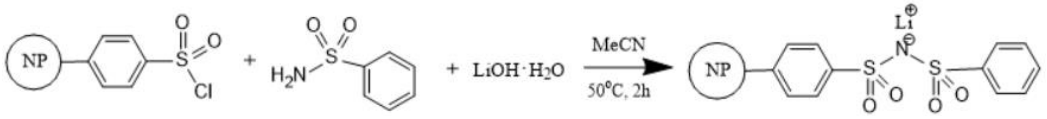
Figure 2. Synthesis of PSPhSILi.